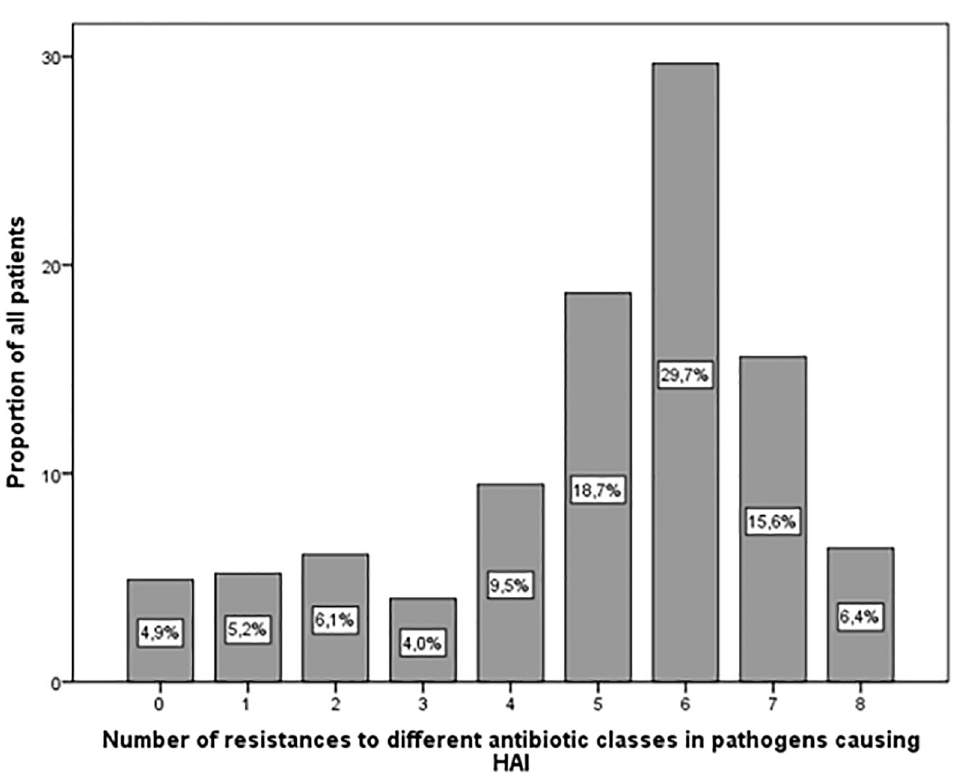
Fig 1. Multiple antibiotic resistance (MAR). Proportion of patients with hospital-acquired infections caused by gram- negative bacteria (GNB) with antibiotic resistance (ABR) to between 0 and 8 antibiotic classes. These classes included antipseudomonal cephalosporins, penicillins, carbapenems, fluoroquinolones, aminoglycosides, monobactams, polymyxins, folate pathway